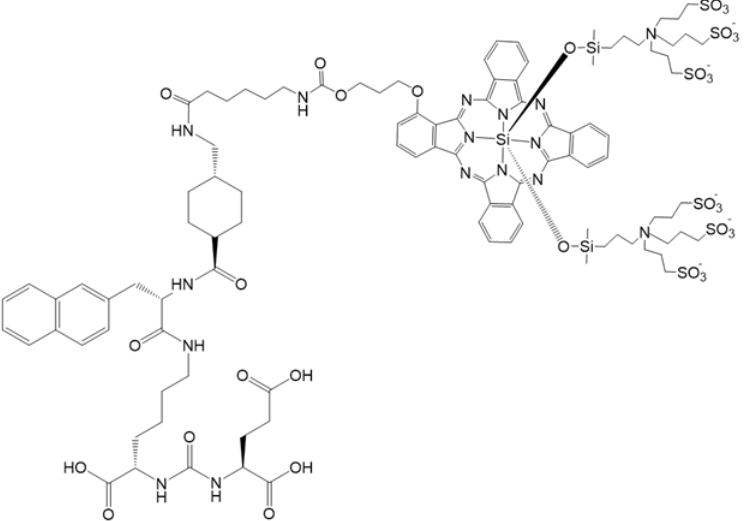
Figure 1. IRDye700DX-PSMA inhibitor molecular structure.